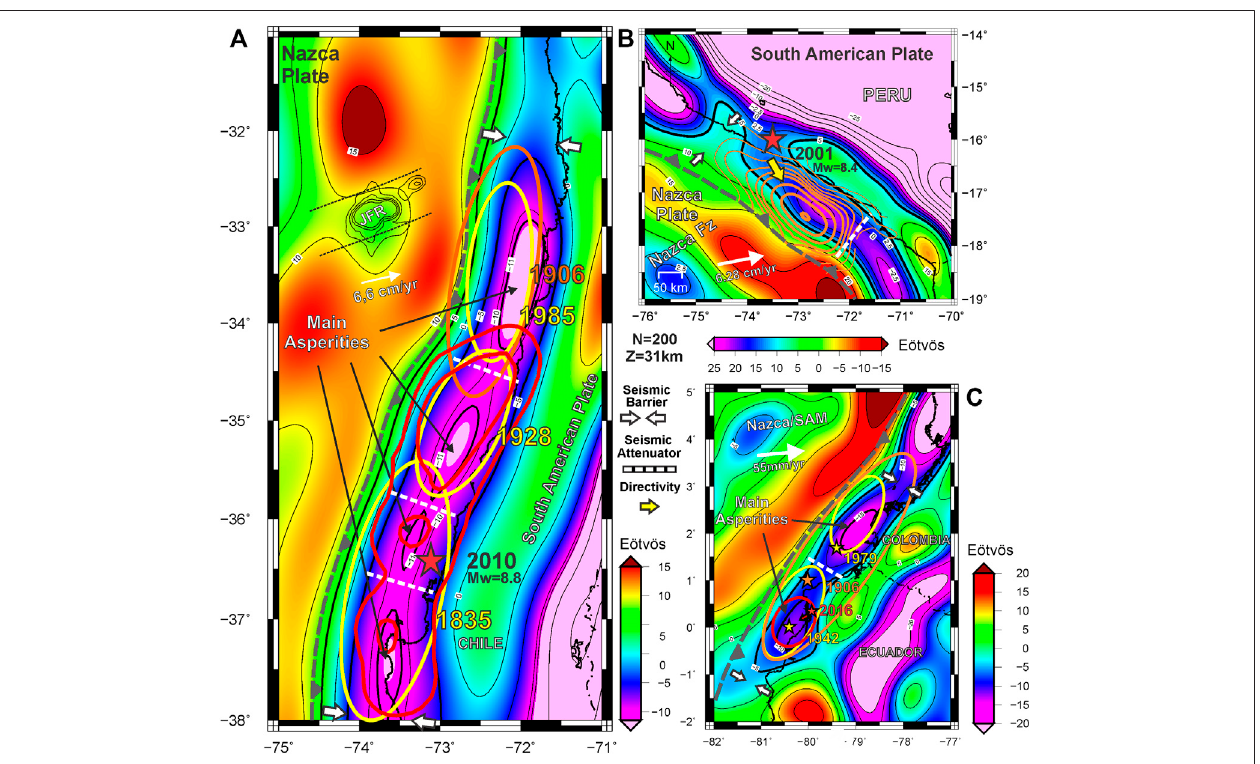
FIGURE2| TopographycorrectedverticalgravitygradientobtainedfromGOCEsatellite-onlymodelGO_CONS_GCF_2_DIR_R5(Bruinsmaetal.,2013)uptoN (cid:1) 200. (A) Slipdistribution(redsolidline)fortheMw (cid:1) 8.82010Mauleearthquake(Morenoetal.,2012),the − 5 Eötvöscontour(thickblackline)roughlycoincideswiththeseismogeniczone along the forearc. The − 10 Eötvös contour coincides with the location of maximum slip lobes. Solid white arrows indicate a narrowing of the Tzz minima contours, which correspondstomainsliplimitsalongstrike(Alvarezetal.,2014;Alvarezetal.,2019b).Nazca-SouthAmericanplatesconvergence(blackarrow)isfromDeMetsetal.(2010). (B) Slip distribution for the Mw (cid:1) 8.4 2001 Arequipa earthquake (Chlieh et al., 2011). The +5 Eötvös contour (thick black line) depicts higher densities to the NW and SE of the epicenter along the forearc (Alvarez et al., 2015; Alvarez et al., 2019a). A low Tzz anomaly to the SSE of the epicenter connects to the maximum slip, following the rupture propagationintheSouthwarddirection(blankwhitearrow).Nazca-SouthAmericanplatesconvergence(whitearrow)isfromKendricketal.(2003). (C) Historicalrupturesalongthe Ecuador-Colombiamargin(Alvarezetal.,2017b;Alvarezetal.,2019b).Redstarindicatestheepicenter ’